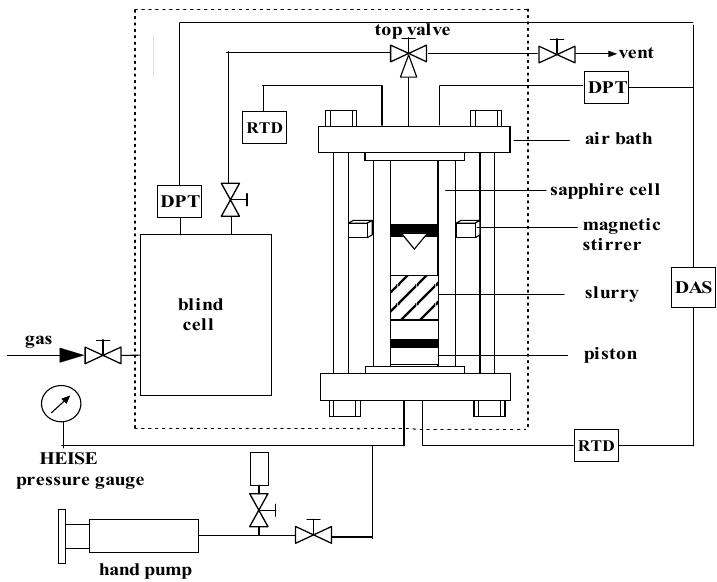
Figure 3. Schematic diagram of the experimental apparatus for hydrate formation: RTD, resistance thermocouple detector; DPT, differential pressure transducer; and DAS, data acquisition